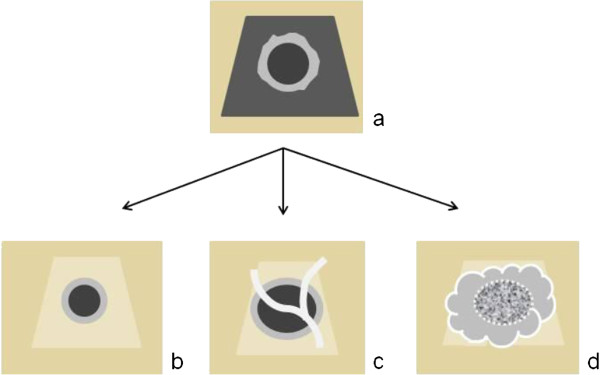
Schematic representation of the target-shaped lesion at 3 months (a), note the hypodense area and the surrounding rim enhancement; after 3 months in case of local control(b,c), the lesion becomes smaller(b), retains its size, or even grows surrounded by a thin rim enhancement with total necrosis (c); and (d) in case of local recurrence, note the heterogeneous center surrounded by lobulated irregular thick enhancement; Note the shrinkage of the hypodense area that becomes hyperdense in all cases.